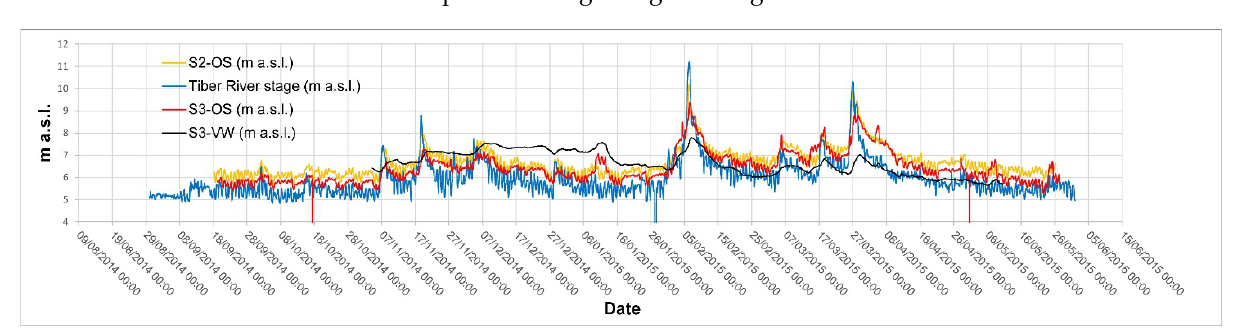
Table 6. Statistical parameters of the calibrated model.